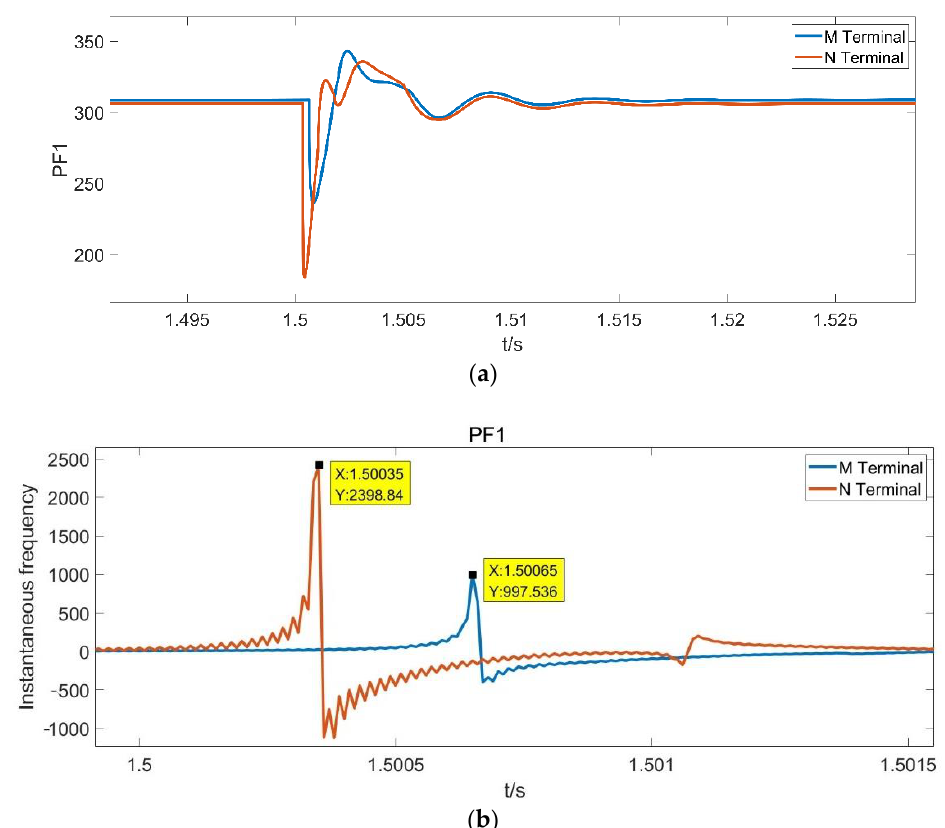
Figure 9. Analysis of faults at 130 km using ILMD. ( a ) PF1 component of six-mode voltage. ( b ) Instantaneous frequency curve.